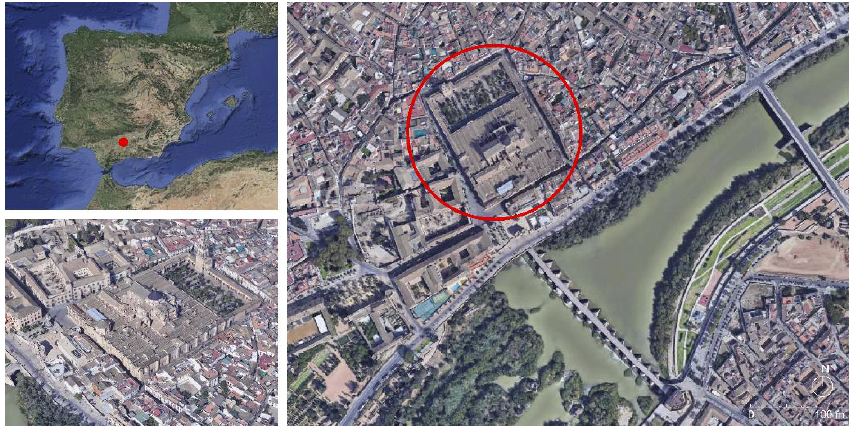
Figure 1. The geographical location of Cordoba in southern Europe and the Mosque-Cathedral placement downtown near the Guadalquivir river and Roman bridge.